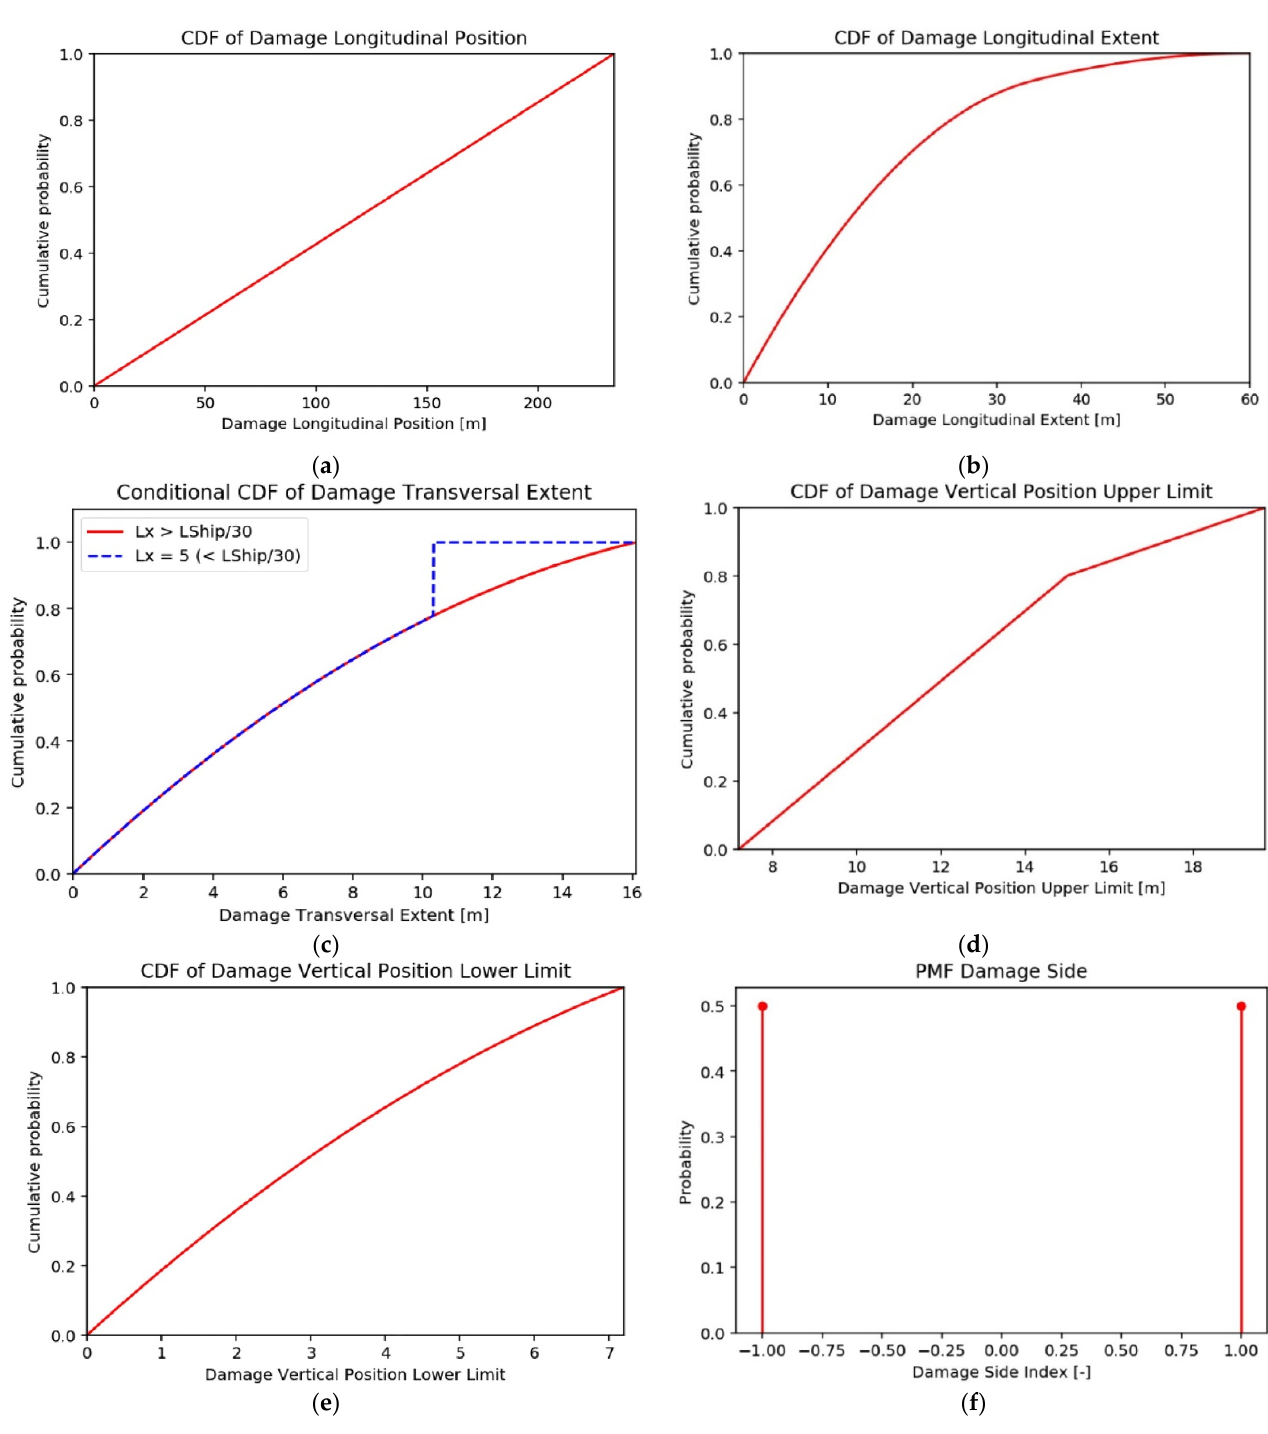
Figure 4. ( a ) Damage centre longitudinal position cumulative distribution function; ( b ) Damage lon- gitudinal extent cumulative distribution function; ( c ) Damage transversal extent conditional cumu- lative distribution function; ( d ) Damage vertical position upper limit cumulative distribution func- tion; ( e ) Damage vertical position lower limit cumulative distribution function; ( f ) Damage side in- dex probability mass function.